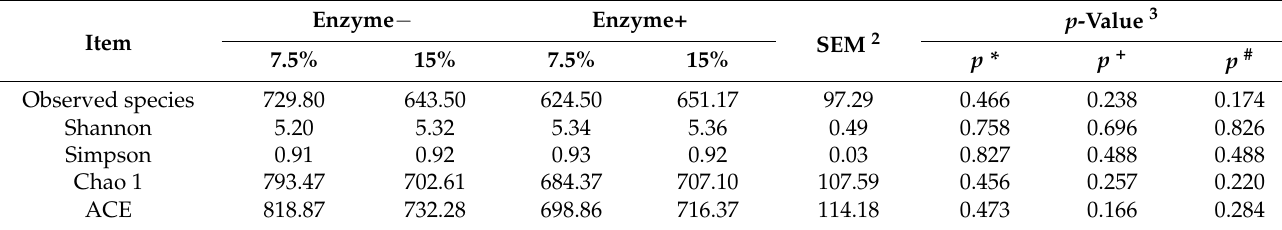
Table 8. The alpha diversity in the fecal microbiome of weaning piglets 1 .